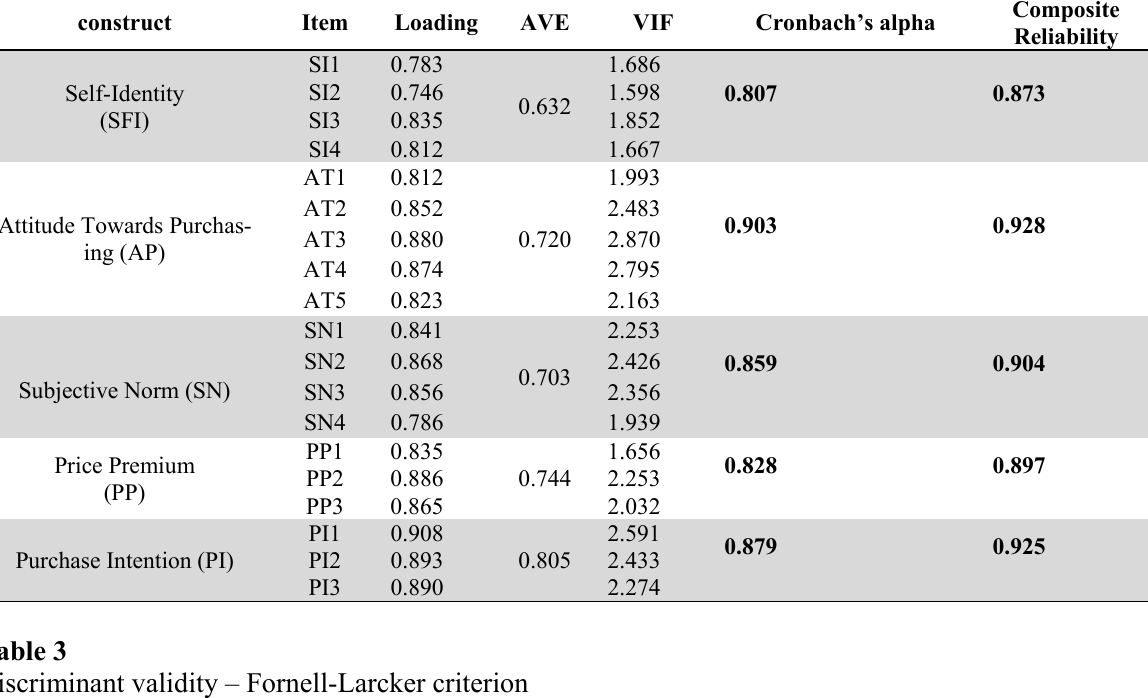
Discriminant validity – Fornell-Larcker criterion Construct